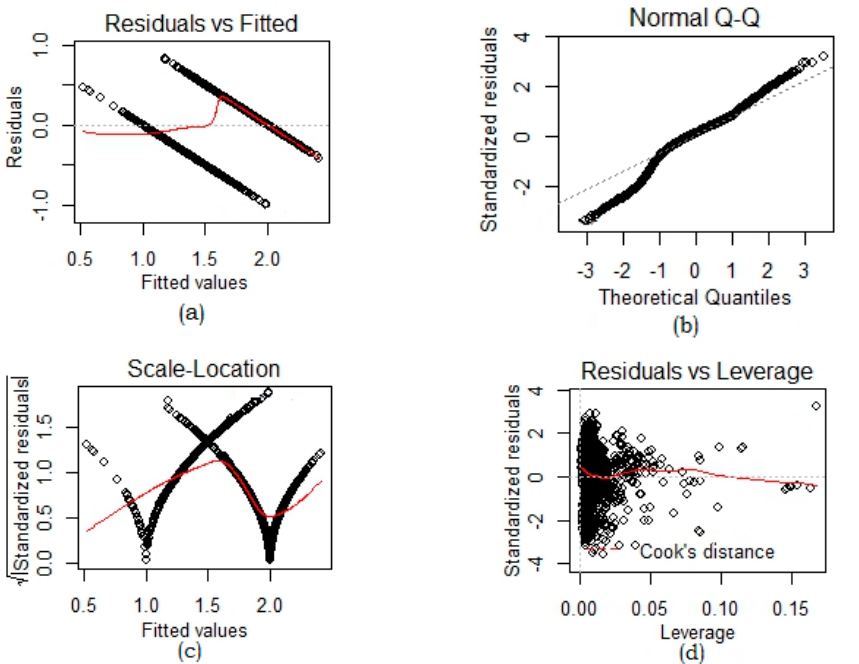
Figure 2. This figure is the validation of the linearity of the dataset using test plots: ( a ) indicates that there is a linear link between predictor factors and outcome variables and residuals have linear patterns; ( b ) illustrates that the residuals are normally distributed because a straight dashed line is well lined with residuals; ( c ) is the scale-location plot and confirmed that residuals are distributed evenly across the predictors’ range; ( d ) exhibits the significant data points by using Cook’s